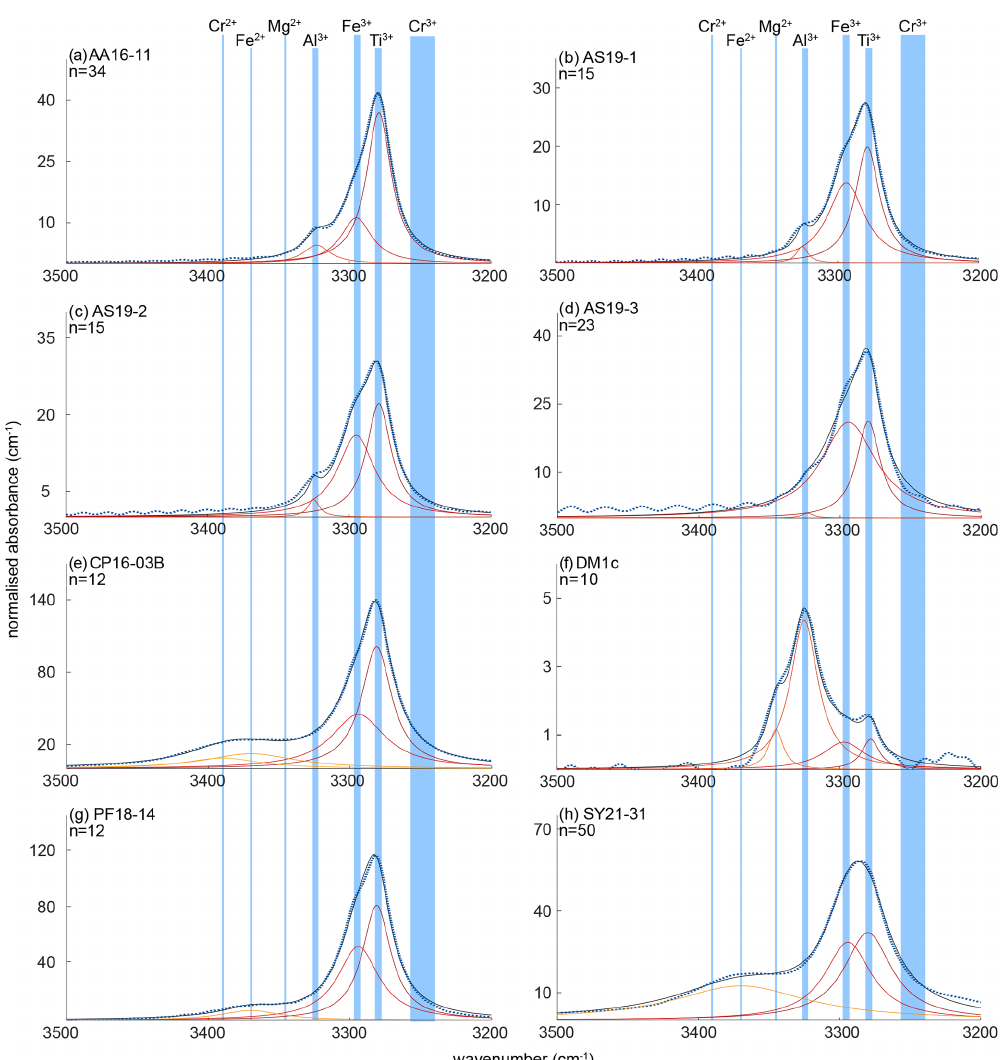
Figure 6. Trace-element-dependent OH-band positions in natural rutile. Black lines are averages of n measured FTIR spectra. Orange and red dashed lines are trace-element-specific OH spectra as resulting from peak deconvolution. Blue dashed lines are cumulative spectra. Vertical blue lines depict the OH-band ranges. Ranges are 3278–3281cm − 1 for Ti 3 + , 3294–3297cm − 1 for Fe 3 + , 3323–3325cm − 1 for Al 3 + , 3345cm − 1 for Mg 2 + , 3370cm − 1 for Fe 2 + , and 3390cm − 1 for Cr 2 + . The wavenumber range of Cr 3 + (3240–3257cm − 1 ) is taken from experimental results by Kamperman (1996) and Bromiley and Hilairet